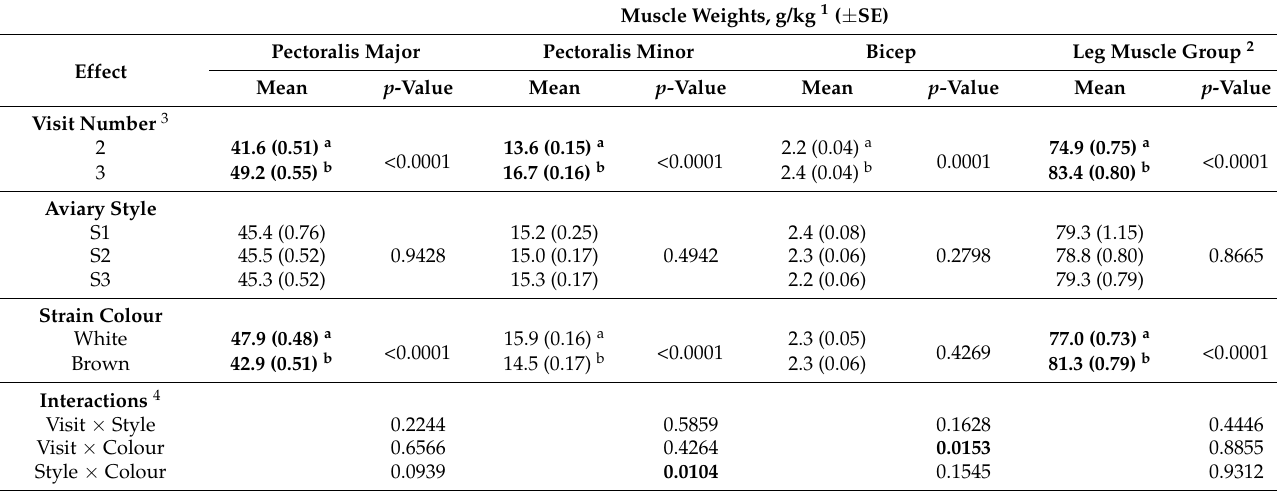
Table 7. Least square means ( ± standard error) of the proportional muscle weight (g/Kg) of the pectoralis major, pectoralis minor, bicep, and leg muscle group of layer pullets housed in three different styles of commercial rearing aviary systems of increasing structural complexity at approximately 10 and 16 weeks of